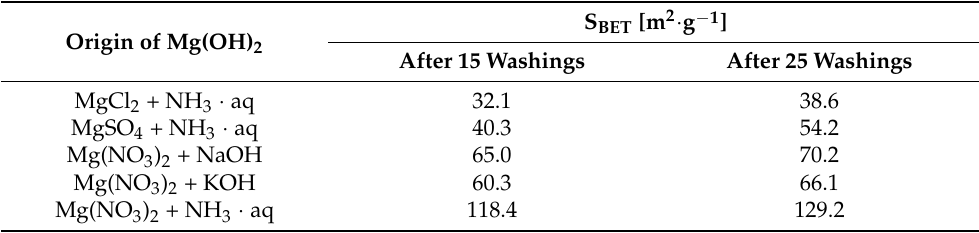
Table 8. Effect of the number of times applied in washing Mg(OH) 2 on the specific surface area of MgO obtained from different precursors by calcination of Mg(OH) 2 at 873 K for 6 h. Origin of Mg(OH) 2